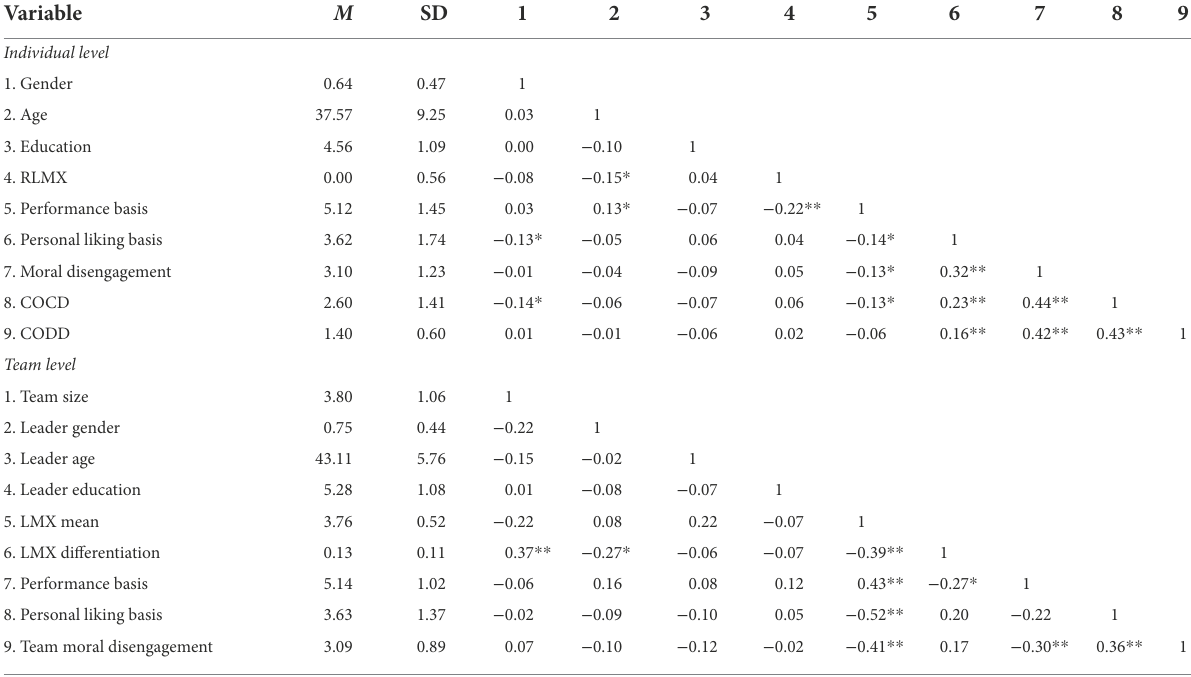
TABLE 1 Means, standard deviations, and intercorrelations among study variables.